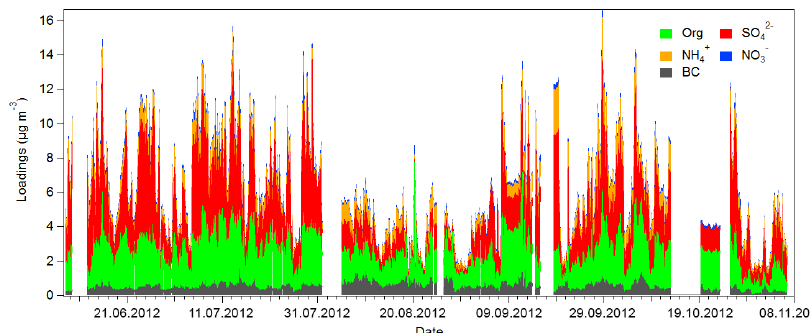
Figure 1. Time series of the main submicron aerosol components at Finokalia, Crete, during the measurement period in 2012.